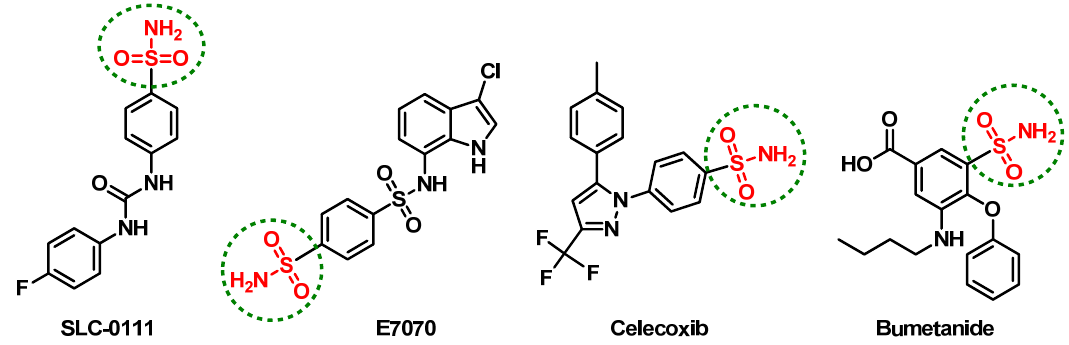
Figure 1. The chemical architecture of promising anticancer sulfonamides in clinical trials or currently in-use pharmacotherapeutics with inhibition activity on the tumor-associated human carbonic anhydrases (Cas).